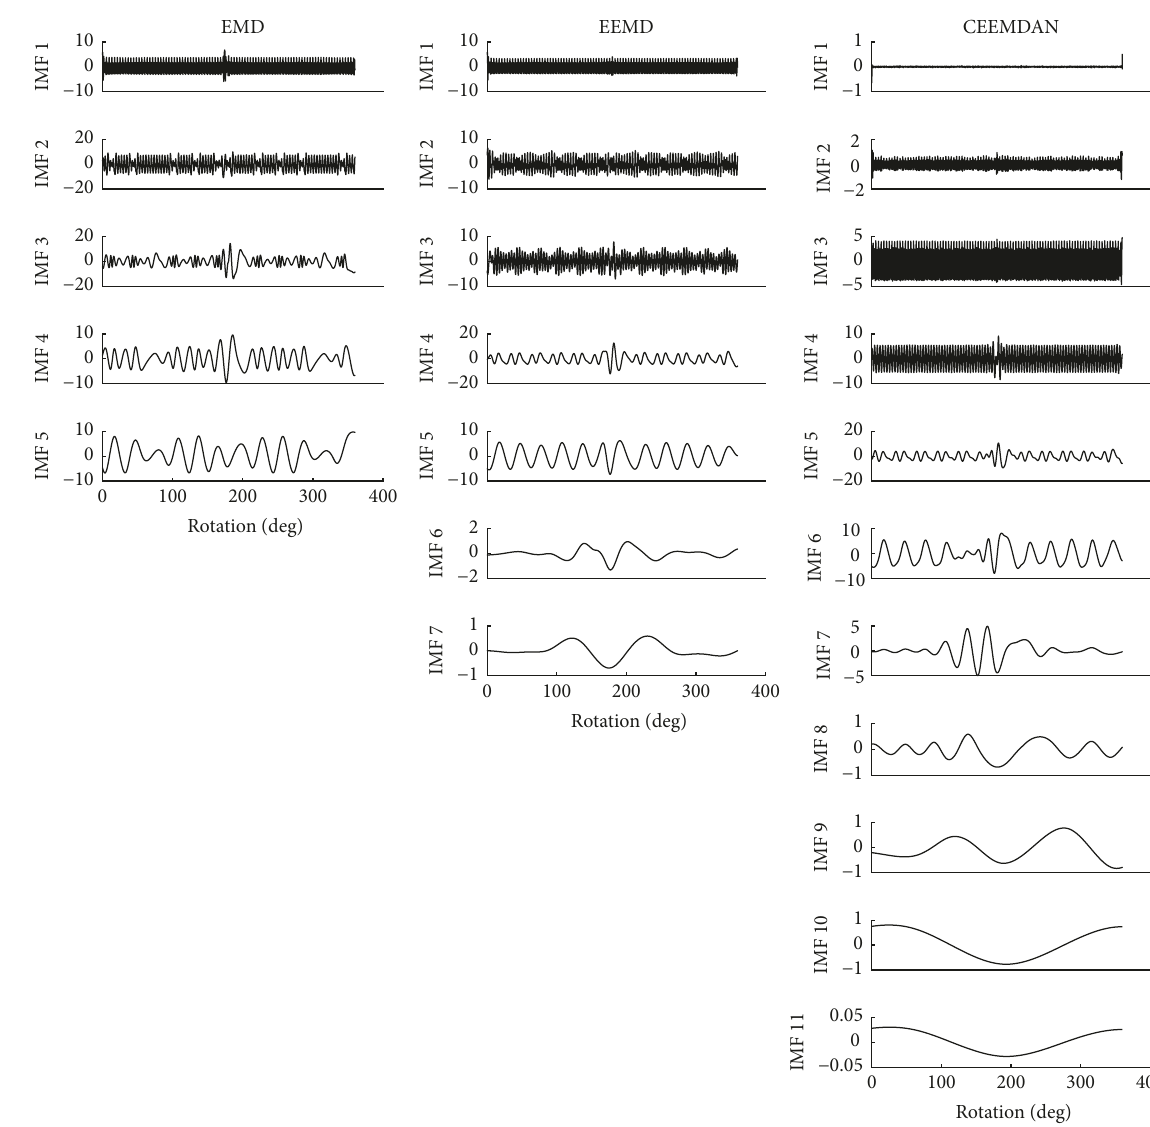
Figure 8: IMF sets of 𝑥 sim , III obtained by using EMD, EEMD, and CEEMDAN.